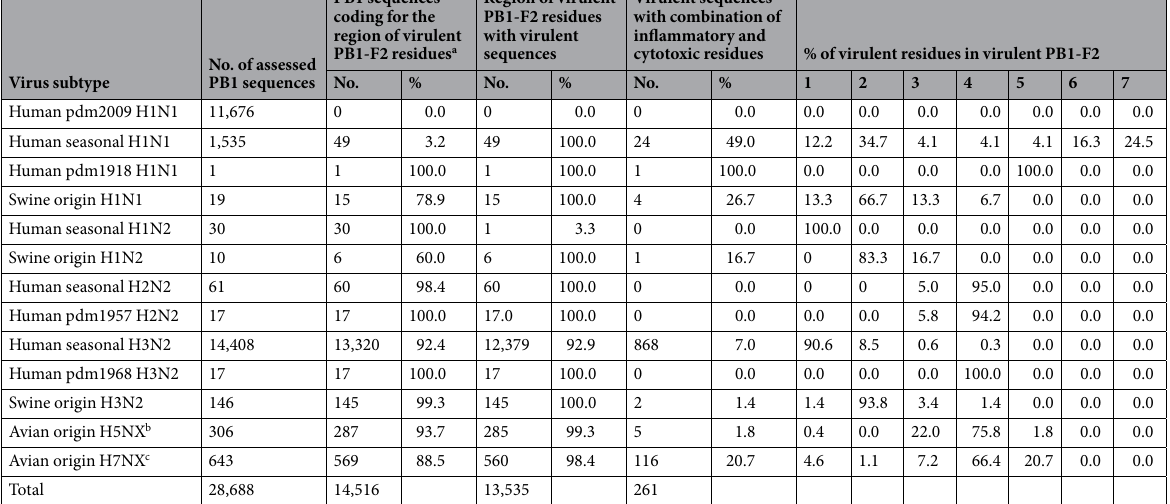
PB1-F2 residues, IAV with zoonotic potential maintain a reservoir of virulent PB1-F2. In general, human isolates of zoonotic swine or avian IAV had a higher number of virulent residues than did seasonal IAVs. For example, over 80.0% of PB1-F2 sequences from H1N1, H1N2, and H3N2 human isolates of swine origin contained two or more virulent residues (Table 1, Fig. 1 and Supplementary Table 1). Humans have been infected with avian IAVs of the H5Nx and H7Nx subtypes. Only 949 PB1 sequences encompassing the complete PB1-F2 ORF were available for analysis as of November 25 th , 2017. More than 77% of such isolates with a PB1-F2 protein of 62 residues or more contained four to five virulent residues. Combinations of inflammatory and cytotoxic residues were notably present in PB1-F2 from human isolates of swine and avian origin. Typically, these swine and avian origin viruses contained the cytotoxic residue I68 on their PB1-F2, in addition to inflammatory residues. Virulence of PR8(H1N1) PB1-F2-derived peptides in mice. Since PB1-F2 of contemporary human IAVs of all subtypes may possess combinations of inflammatory and cytotoxic residues, we next evaluated the effect of inflammatory residues alone or in combination with cytotoxic residues in H1N1 virulence. Chemically synthesized 27-mer C-terminal PB1-F2 peptides were shown to predict the virulence of PB1-F2 proteins with the same sequence 16,31 . We intranasally (i.n.) treated mice once with various doses of PR8 PB1-F2 wild-type (WT), lacking cytotoxic ( Δ C), inflammatory ( Δ I), or both motifs ( Δ C Δ I) peptides (peptides’ sequences are shown in Fig. 2). Treatment with 15 mg/kg of peptides lacking one of the two virulent motifs ( Δ C or Δ I) led to less weight loss than did the WT peptide (p < 0.001; Fig. 3a). However, peptide ∆ I induced more weight loss than ∆ C (p < 0.001), suggesting that the cytotoxic motif influences the PB1-F2 virulence to a greater extent than the inflammatory one. Peptide Δ C Δ I induced the least weight loss (p < 0.001; Fig. 3a), and was the only peptide whose lung histopa- thology (Fig. 3b) and mortality rates at doses 30 and 60 mg/kg (Fig. 3c) significantly differed from that of the WT (p < 0.02). The absence of significant differences in lung histopathology between the WT, Δ C, or Δ I at day 3 after peptide administration, but reduced weight loss of Δ C or Δ I compared to the WT through the course of study, suggest that even if the lung damage was comparable between three peptides at this early time-point, the healing process was much faster in case of peptide without either the inflammatory or cytotoxic motif. In a model to test susceptibility to secondary bacterial pneumonia, we treated mice with a non-lethal dose of 10 mg/kg of each PR8 PB1-F2-derived peptide, or with PBS as a control, and one day later challenged them with 2,000 colony-forming units (CFU) of S. pneumoniae (SPn). With this dose of SPn, more than 90% of control mice (treated with PBS instead of peptide) survived (Fig. 4a). Similarly, more than 90% and 100% of mice pre-treated with the ∆ C and ∆ C Δ I peptides survived, respectively. The combination of the SPn with ∆ I or WT peptide resulted in 50% mortality. Reflecting the general mortality trends, one day post-infection, the highest levels of geometric mean bacterial lung titers (6.4 log 10 CFU/ml) were seen in animals receiving the WT peptide, the lowest (1.0 log 10 CFU/ml) with the ∆ C Δ I, and the peptides containing only one of the virulent sequences ∆ C and Δ I had intermediate titers (4.2 log 10 CFU/ml and 4.58 log 10 CFU/ml, respectively) (Fig. 4b). Histopathological changes in the mouse lungs in the model of bacterial pneumonia (Fig. 4c) paralleled the mortality patterns as well, with the most severe changes seen in WT + SPn, followed by ∆ I + SPn and ∆ C + SPn (overall severity of 31.2 ± 6.3, 20.8 ± 6.0, and 11.7 ± 3.2 by semi-quantitative scoring, respectively). Minimal his- topathological changes were observed in mice receiving ∆ C Δ I + SPn (overall severity of 1.3 ± 1.5; not different